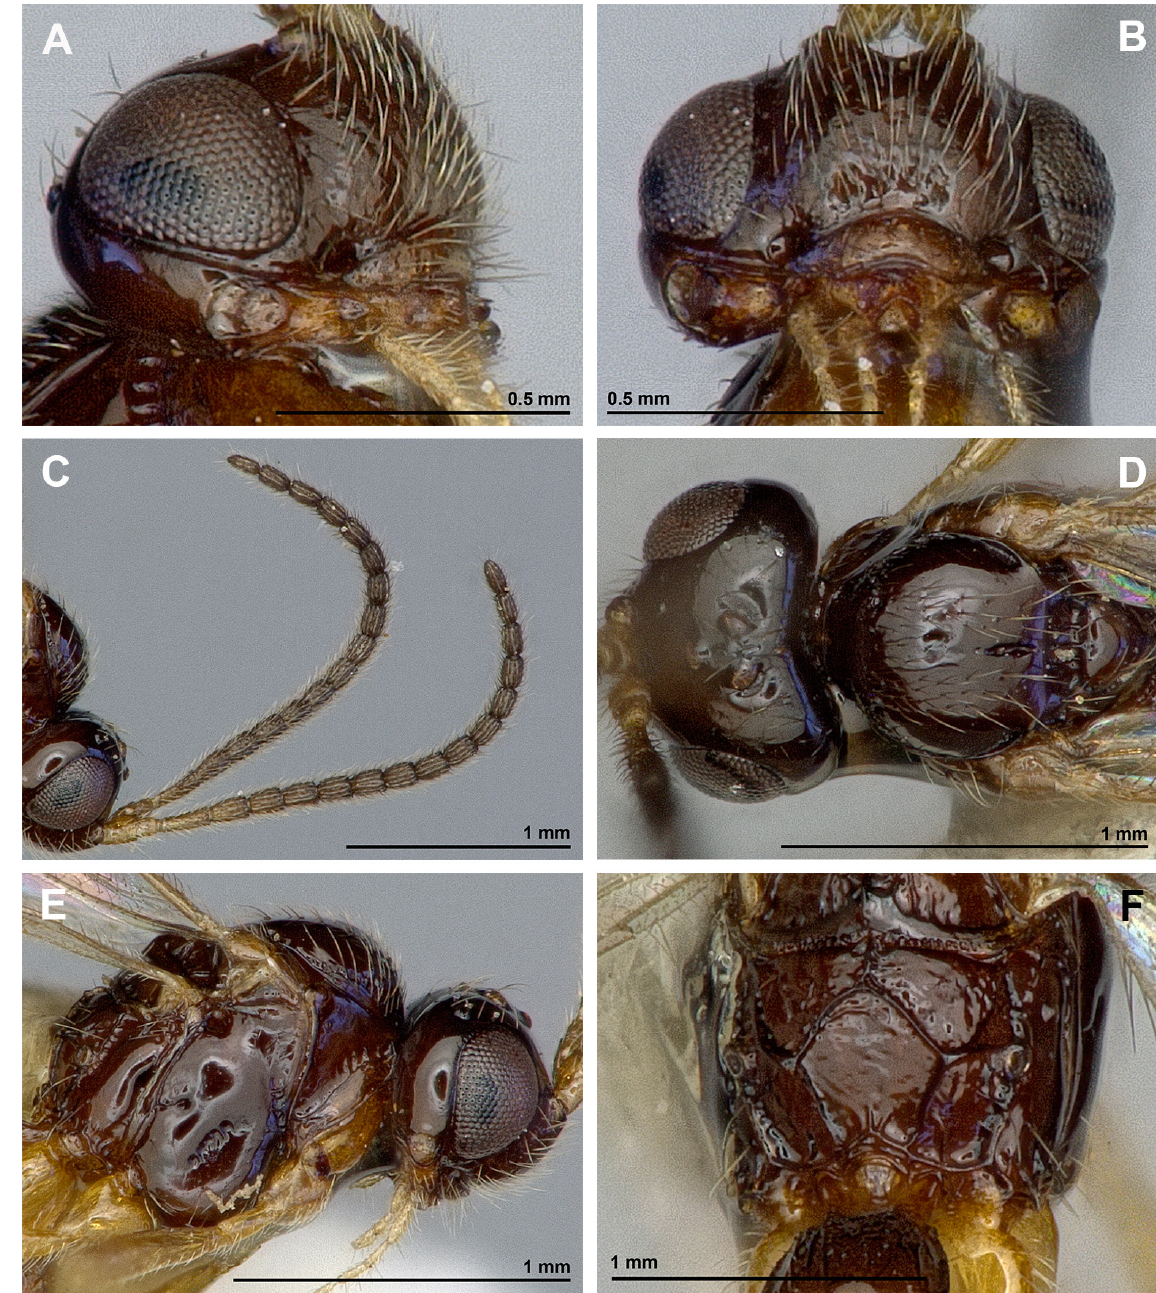
Fig. 6. Dinotrema subbidentatum Peris-Felipo sp. nov. (♀). A . Head and mandible, lateral view. B . Face, frontal view. C . Antenna. D . Head and mesonotum, dorsal view. E . Head and mesosoma, lateral view. F . Propodeum, dorsal